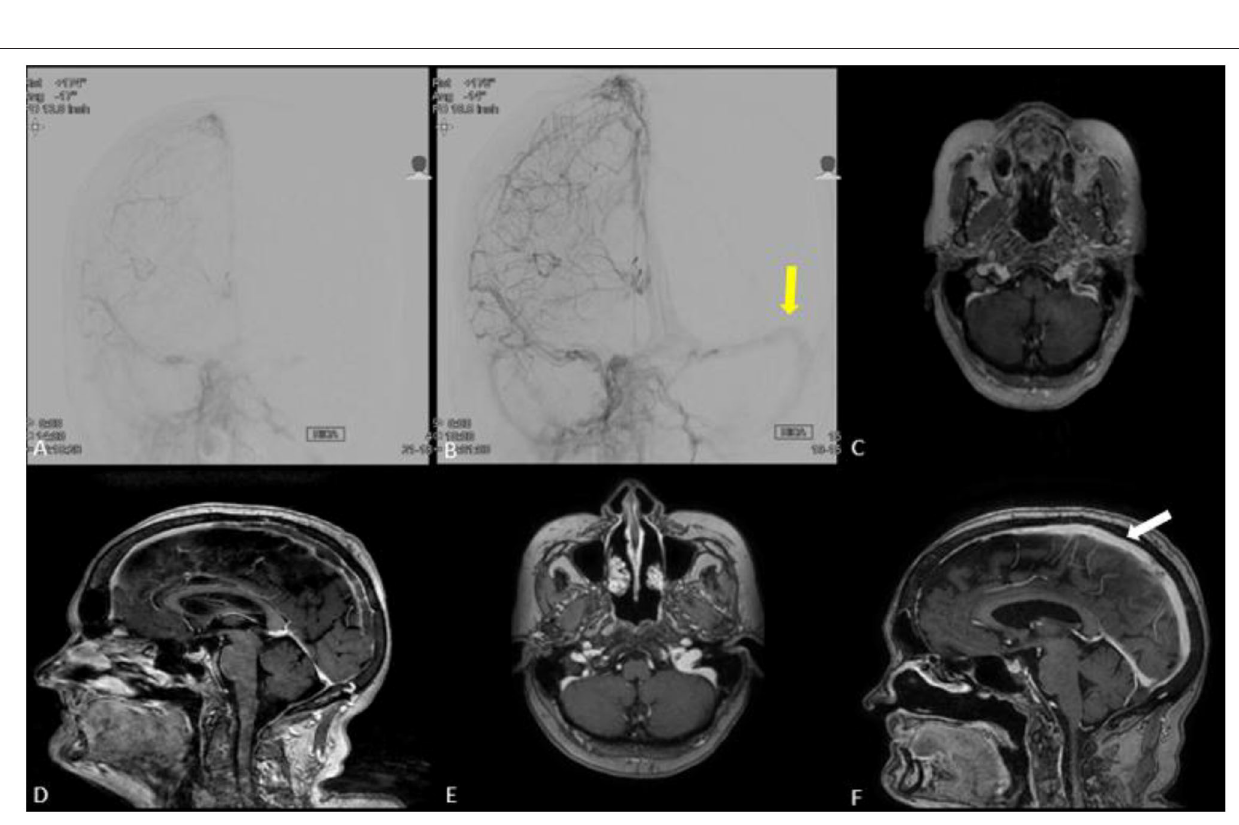
Frontiers in Neurology | www.frontiersin.org